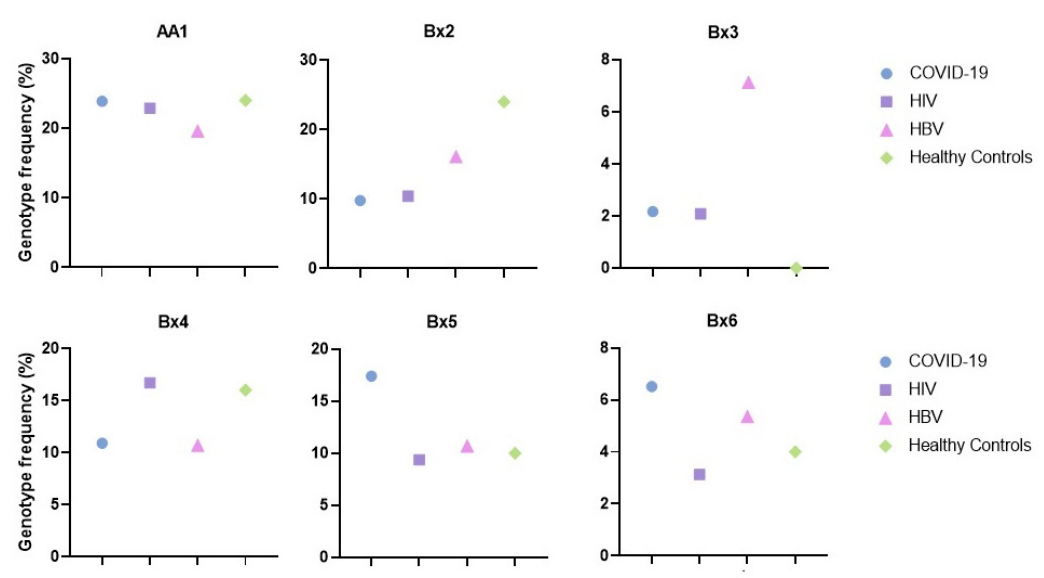
Figure 2. Frequencies of KIR genotypes –AA1, Bx2, Bx3, Bx4, Bx5, and Bx6 in infected and healthy control groups.